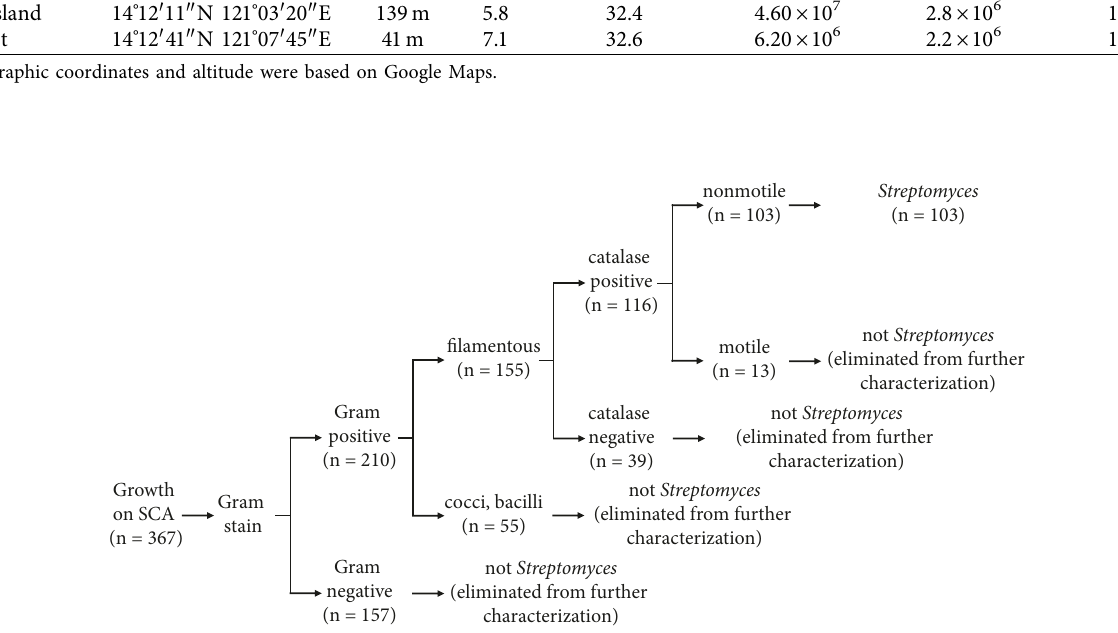
Figure 1: Polyphasic identification of Streptomyces isolates employed in this study (SCA: starch casein